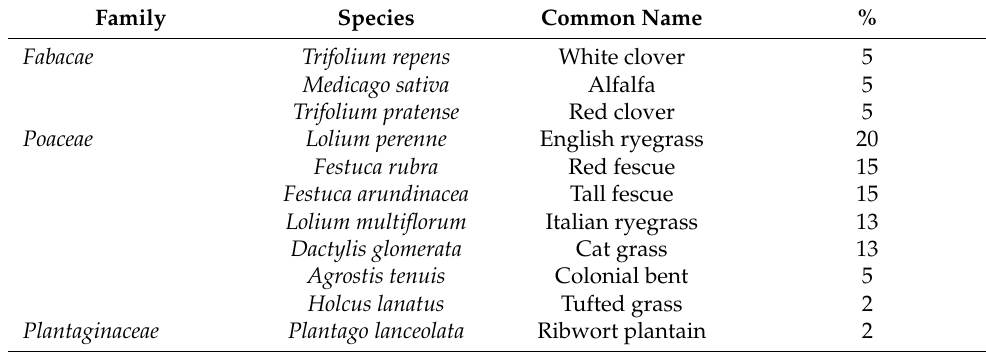
Table 6. Seed mixture used in the